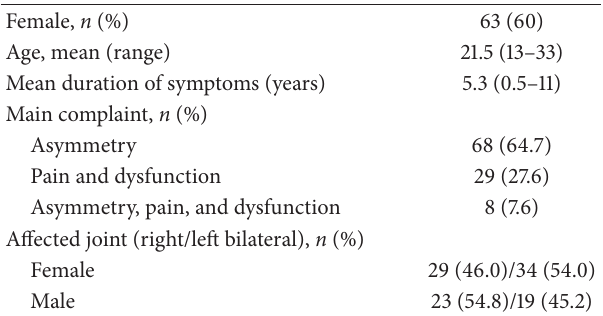
Table 1: Clinical characteristics of the 105 patients diagnosed with